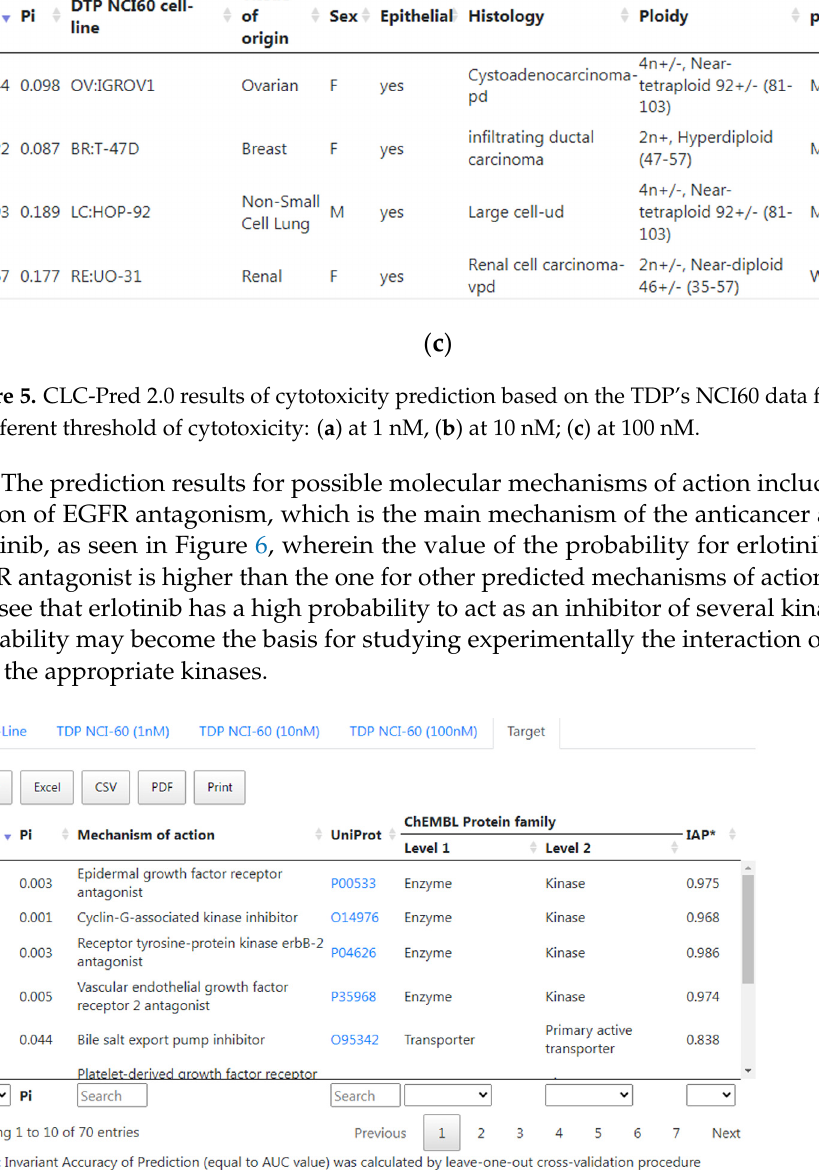
Figure 6. Interface of CLC-Pred 2.0 with prediction results of molecular mechanisms of action for erlotinib.